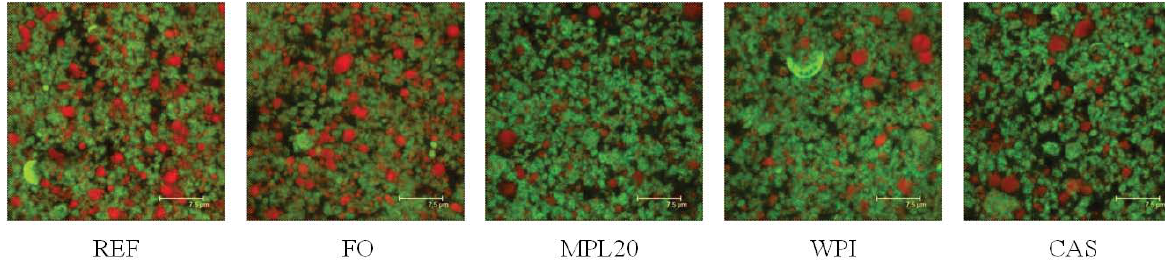
Figure 1. Confocal micrographs of the cream cheeses prepared without fish oil added (REF), with fish oil added as neat oil (FO) or fish oil added in a delivery emulsion emulsified by different emulsifiers (MPL20, WPI and CAS). Lipids are stained red, proteins